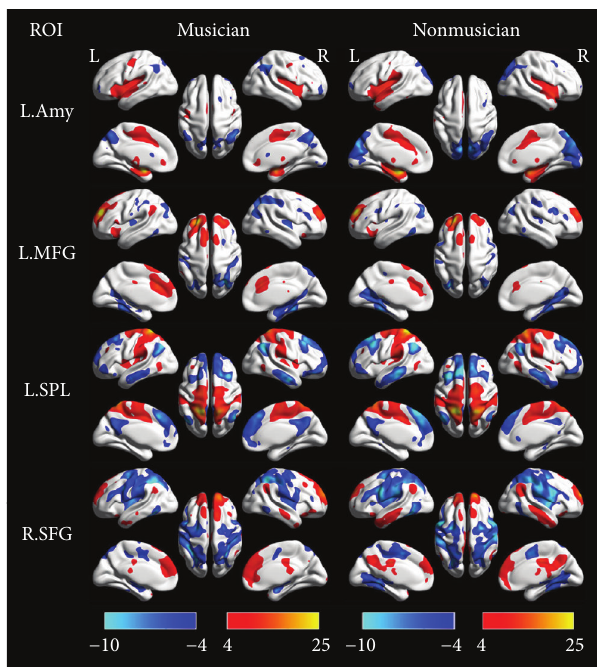
Figure 6: The group-level functional connectivity maps seeded at 4 ROIs. The first column shows the seeds; the second and the third column illustrated the positive (hot color) and negative (cool color) functional connectivity with the seed rendered onto a three- dimension brain reconstruction. ROIs’ abbreviations are consistent with those shown in Table